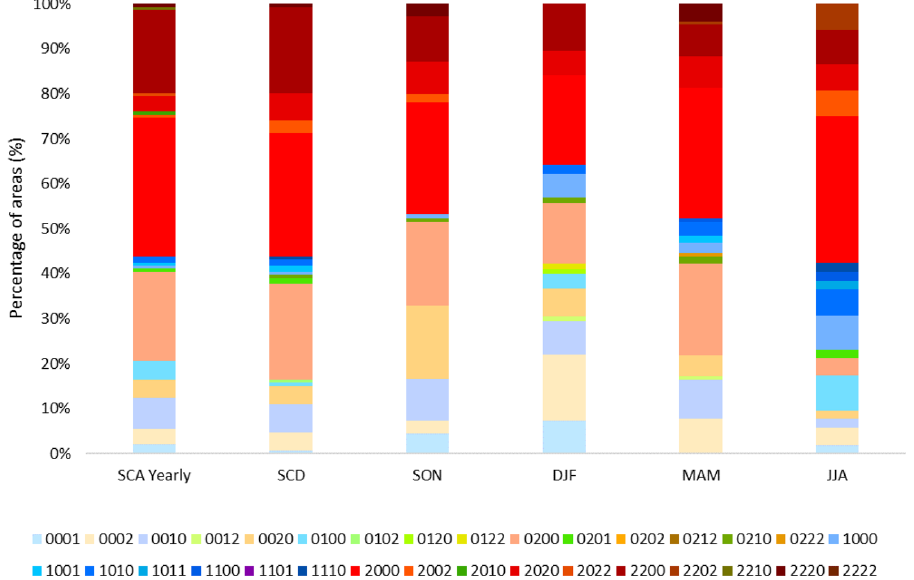
Figure 5. Distributions of the areas (in % with respect to the total number of areas) for trends in different periods. In the legend, the digit of thousands indicates significant trends in 1982–2020, the digit of hundreds in 1982–2000, the digit of tens in 1990–2010, the single digit in 2000–2020. The value “2” indicates negative significant trends and the value “1” represents positive significant trends. For example: “0002” indicates a negative trend for the last period 2000–2020 and no significant trends in the other analyzed period. “2000” indicates a negative significant trend for the period 1982–2020 and no significant trends in the other analyzed periods. The colors in the figure are the same of Figs. S1 and